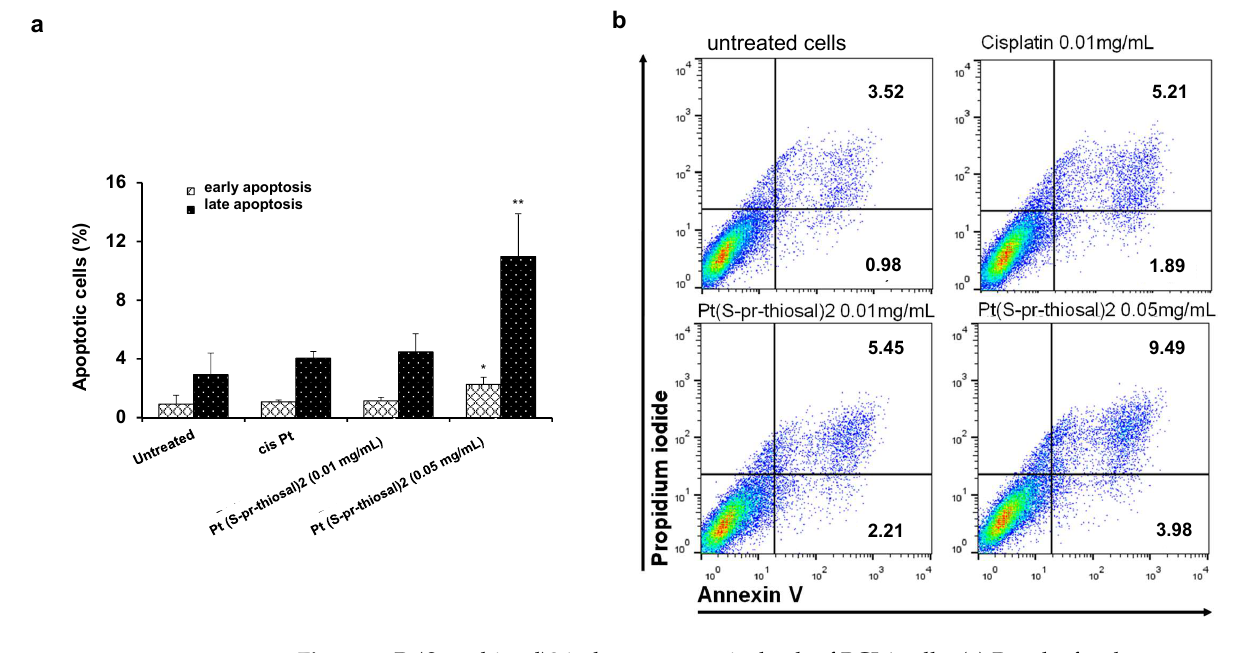
Figure 1. Pt( S -pr-thiosal)2 induces apoptotic death of BCL1 cells. ( a ) Results for the percentage of cells in early (annexin V+ propidium iodide-) and late (annexin V+ propidium iodide+) apoptosis detected by flow cytometry are shown as mean + SD for 3 independent experiments. The statistical significance of the difference in the percentage of apoptotic cells was determined by Student’s t test; * p < 0.05, ** p < 0.01 and indicates the difference in the percentage of BCL1 cells treated with platinum complex at 0.05 mg/mL and all three other groups of BCL1 cells (untreated; treated with cisplatin; and treated with platinum complex at 0.01 mg/mL). ( b ) Representative dot plots show the population of BCL1 cells in early and late apoptosis.